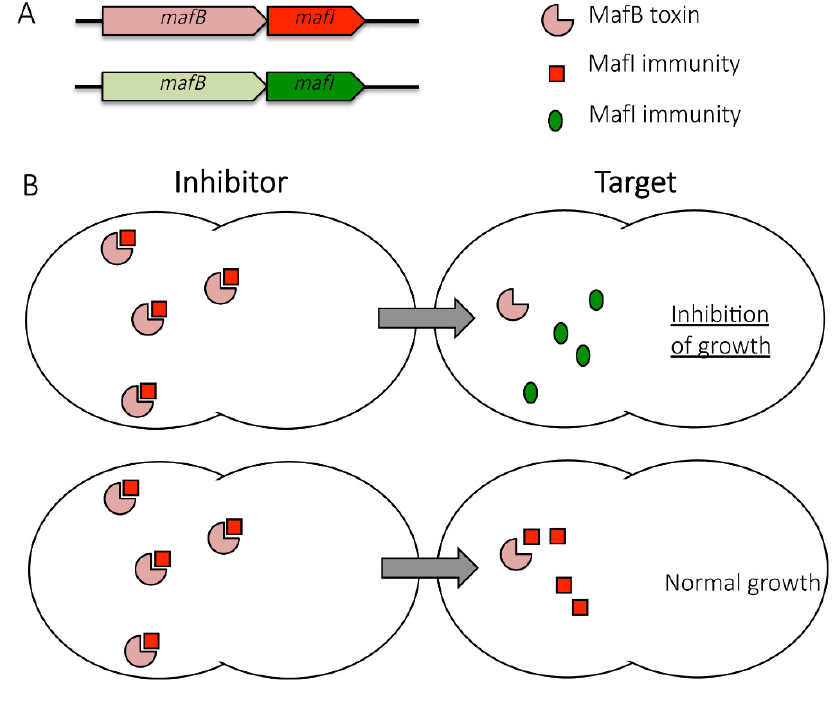
FIGURE 1: MafB toxins are involved in growth inhibition of competitor cells. (A) Genomic organization of mafB and mafI genes. A maf locus contains at least one mafB gene encoding a toxin and one mafI gene encoding the cog- nate immunity. (B) Competition be- tween an inhibitor cell expressing a MafB toxin and a target cell that either lacks or expresses the cognate immunity protein. MafI immunity proteins (blue squares) encoded by mafI gene found immediately downstream of mafB gene neutralize cognate toxins (red three- quarter circles) whereas other MafI immunity proteins (green oval) do not confer